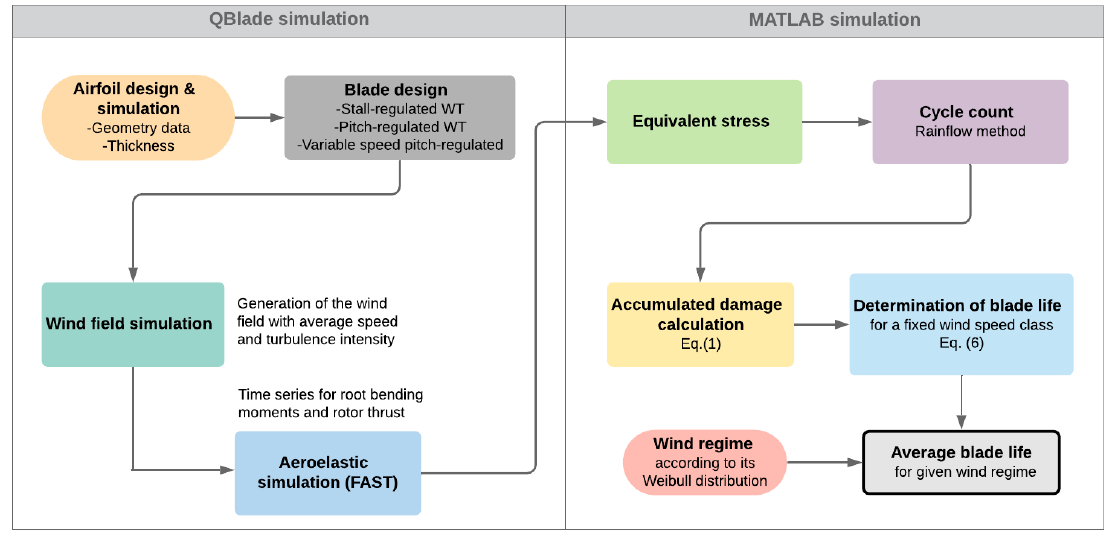
Figure 1. Overall methodology used in this